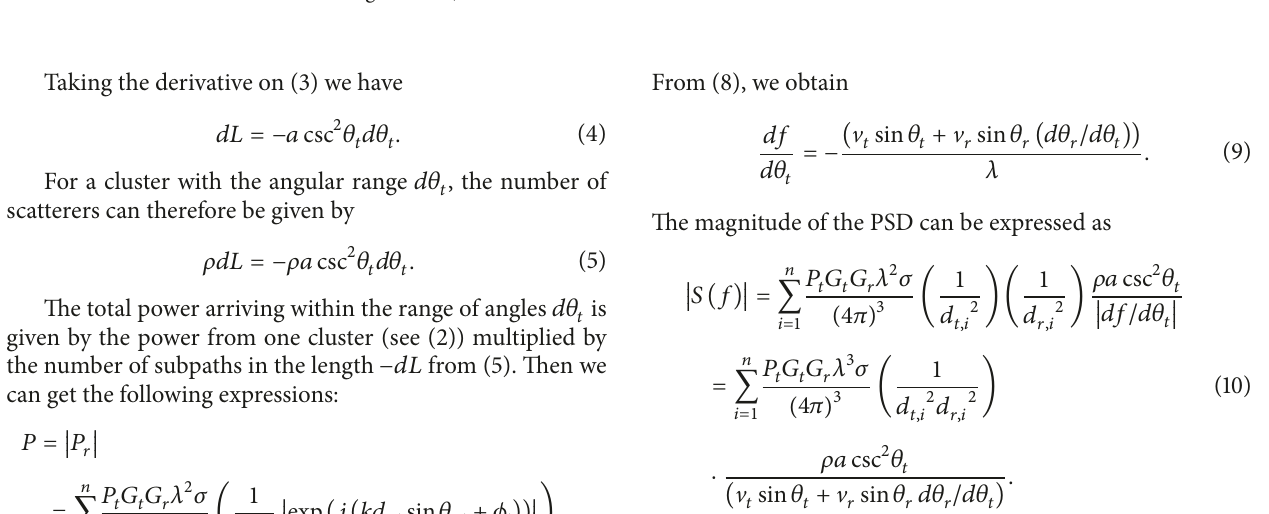
Figure 4: Comparison of CIR performance of different vehicle speeds for the SCM V2V channel model (CIR for vehicles speed from 20 km/h to 80 km/h, omnidirectional transmitting